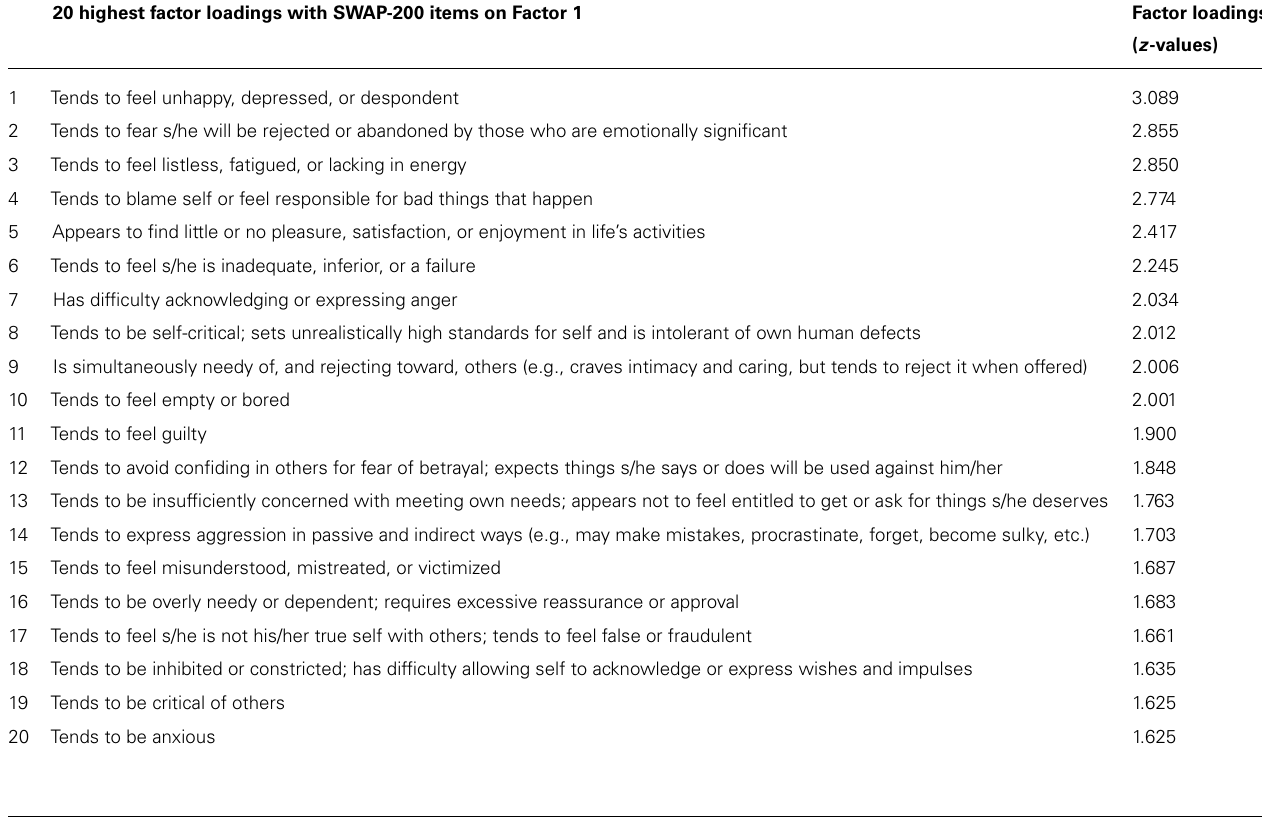
Table 1 |The 20 highest factor loadings on SWAP-200 items for Q-Factor 1 (“Depressive Personality”). 20 highest factor loadings with SWAP-200 items on Factor